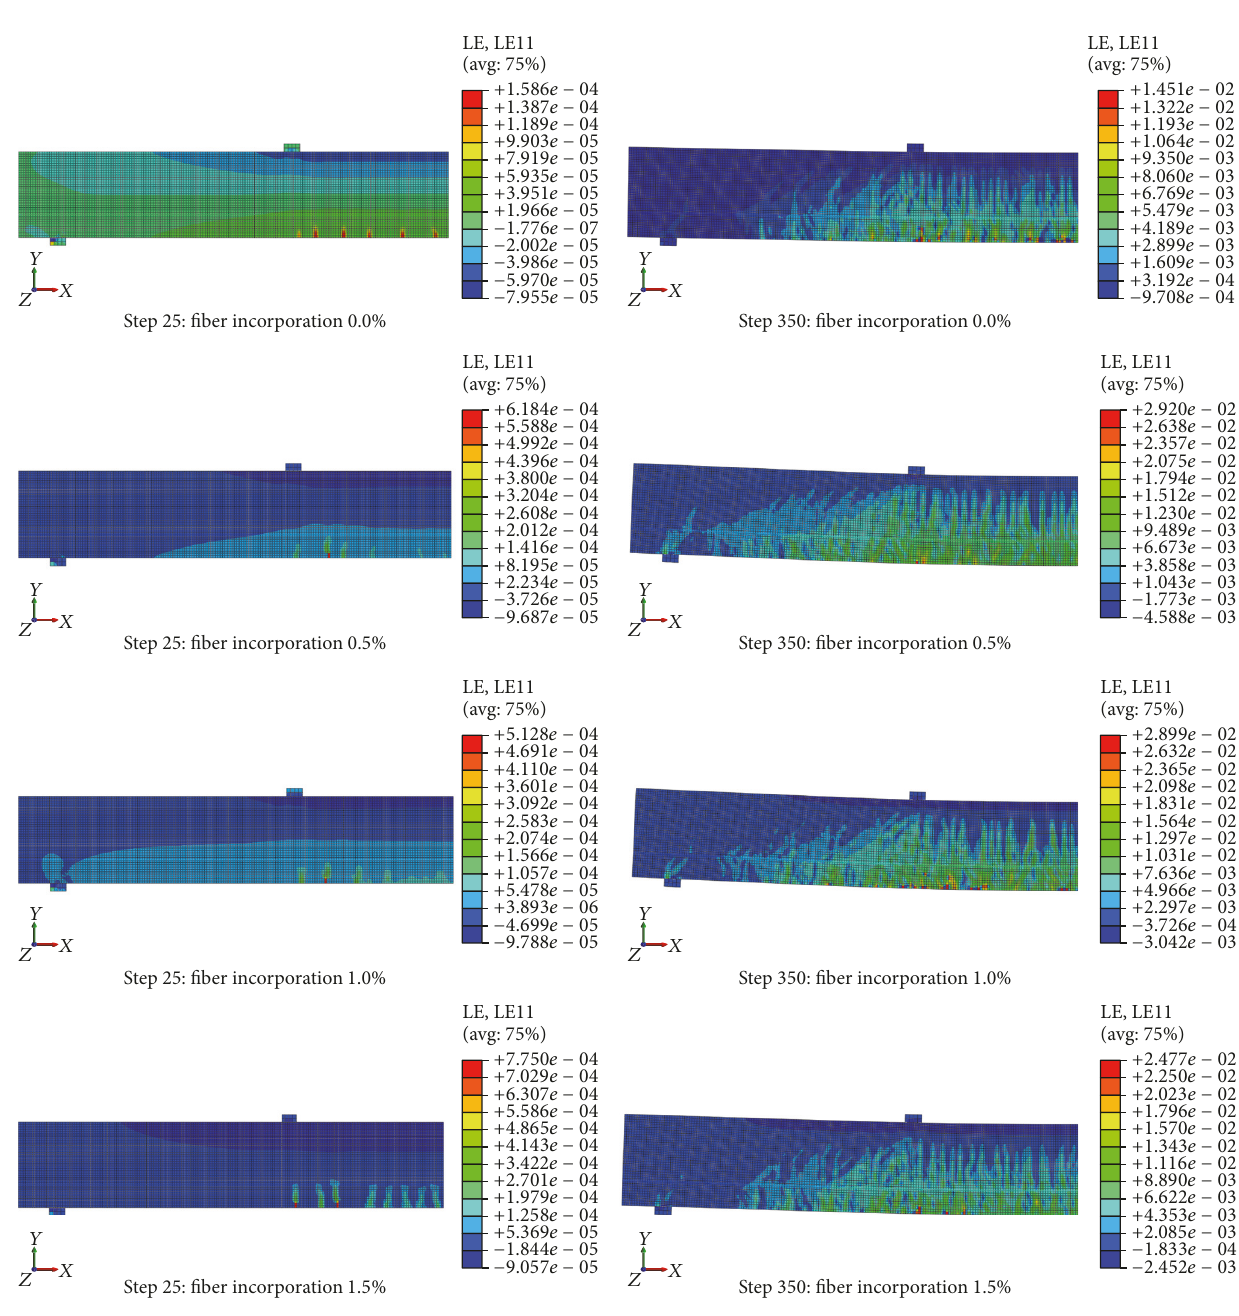
Figure 9: Strain nephogram of GFRP reinforced concrete